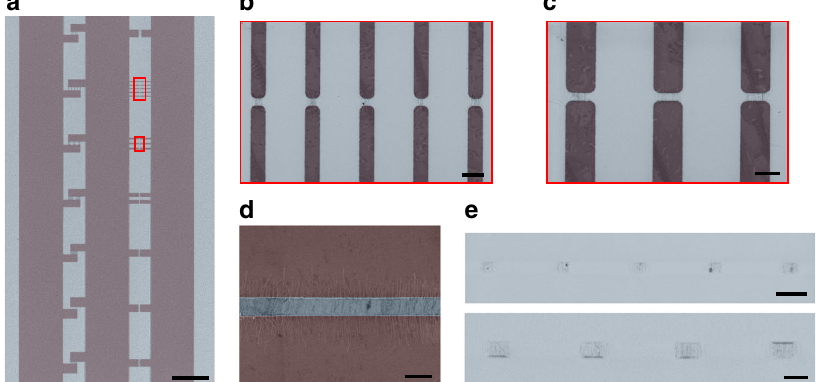
Fig. 3 Pitch and orientation in graphene-based, electric- fi eld-assisted nanomaterial placement. a Scanning electron microscope (SEM) false color image of a graphene layer on a SiC substrate featuring test structures of varying size and orientation for AC fi eld-assisted assembly of carbon nanotubes from solution. The red lines frame the areas that are shown in b , c . Scale bar: 50 µ m. b , c Magni fi ed SEM false color images taken at the positions highlighted by dashed frames showing a representative graphene deposition structures after carbon nanotube placement is completed. Scale bars: 2 µ m. d SEM false color image of an extended graphene electrode pair after placement is completed, exhibiting position and orientation of carbon nanotubes with respect to the gap. Scale bar: 1 µ m. e SEM false color images of carbon nanotube assemblies after removal of the graphene layer leaving only CNTs and some residues. The upper panel corresponds to the area imaged in b . Scale bar: 2 µ m. Deposition conditions are V DEP = 3 V, f = 1 MHz, t = 5